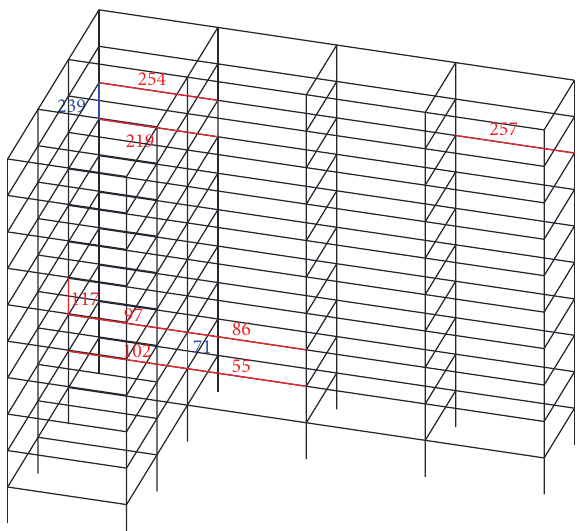
Figure 23: Schematic representation of indicated damaged elements in D5 using incomplete mode shapes.